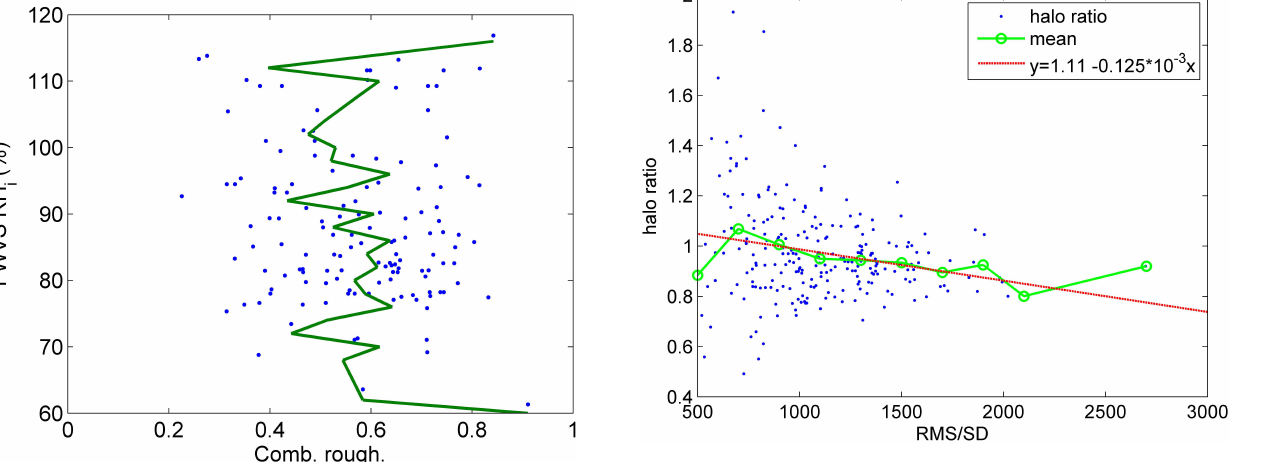
Fig. 8. Relative humidity with respect to ice measured using the FWVS hygrometer on the FAAM aircraft during the cirrus flight B504, plotted against ice particle roughness as represented by the “combined roughness” measure (points) and mean roughness (line). Average temperature during the relevant flight sections was − 54 ◦ C.